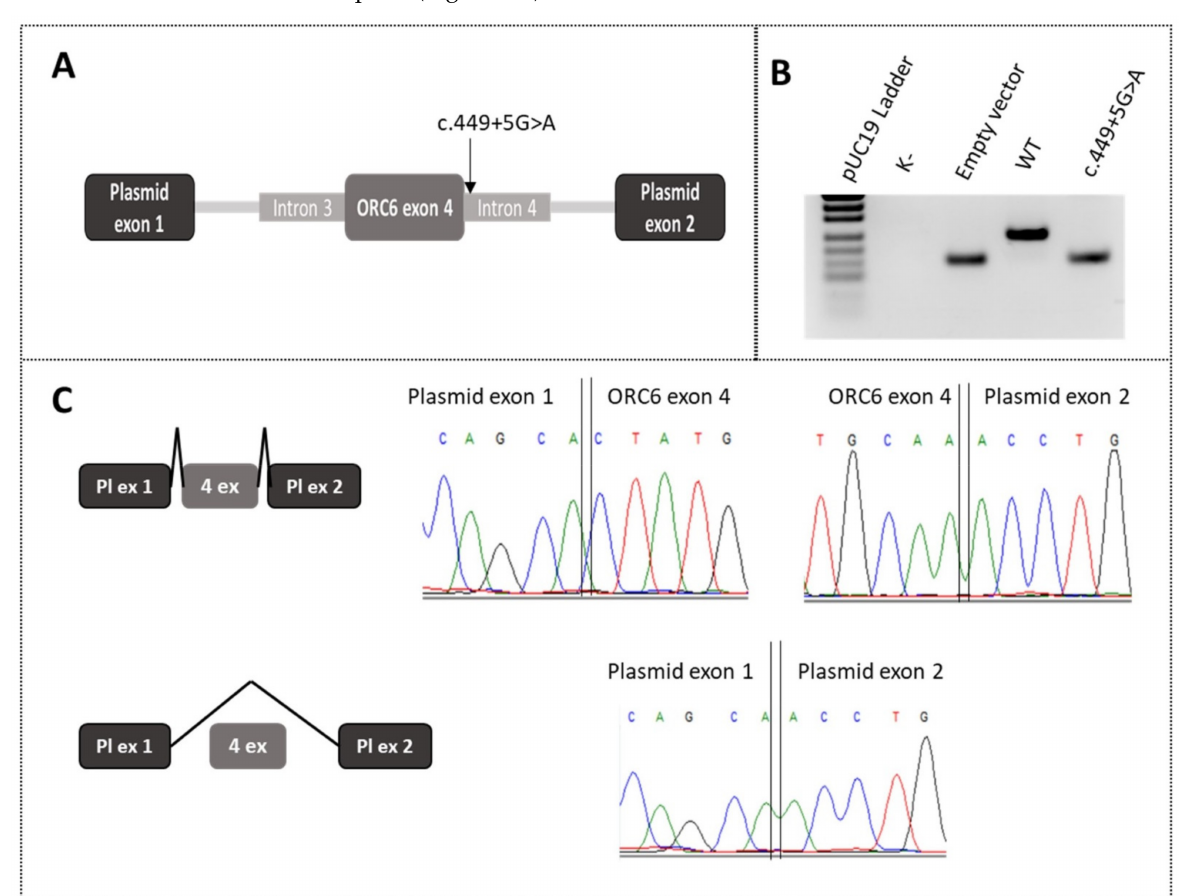
Figure 2. In vitro minigene analysis of c.449+5G>A of the ORC6 gene. ( A ) The scheme of plasmid construction for the minigene assay; ( B ) an agarose gel image from RT-PCR analysis of chimeric transcripts; ( C ) results of Sanger sequencing of splicing products in minigenes. Each construct was transfected into HEK293T cells. After 48 h, the cells were lysed, RNA from the cells was extracted and reverse transcribed, and PCR analysis was